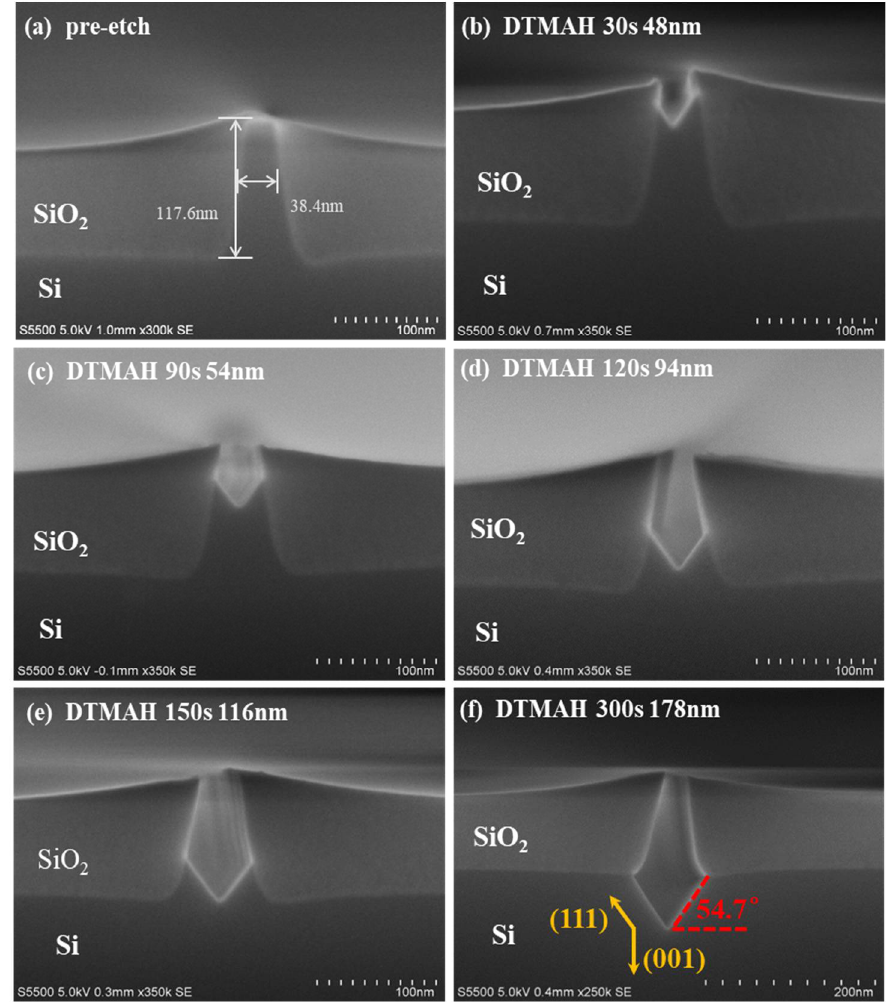
Figure 5. Depth and morphology of 2.5% DTMAH wet etching under different experimental times at room temperature: ( a ) before etching; ( b ) 30 s; ( c ) 90 s; ( d ) 120 s; ( e ) 150 s; and ( f ) 300 s.